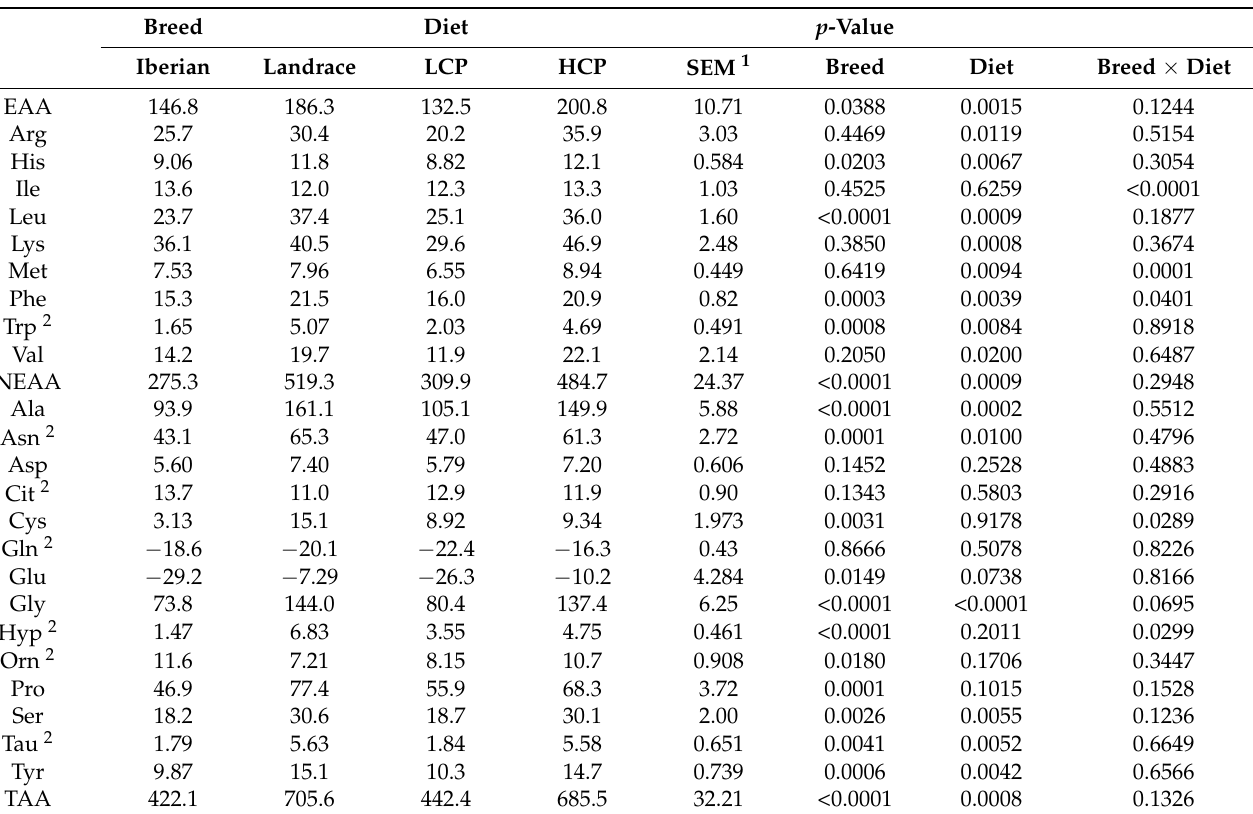
Table 2. Net portal appearance (NPA; µ mol/min) of EAA, NEAA and total AA in Iberian